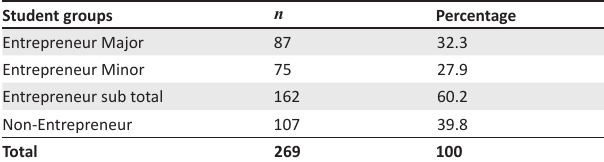
TABLE 1: Sample of final-year students.